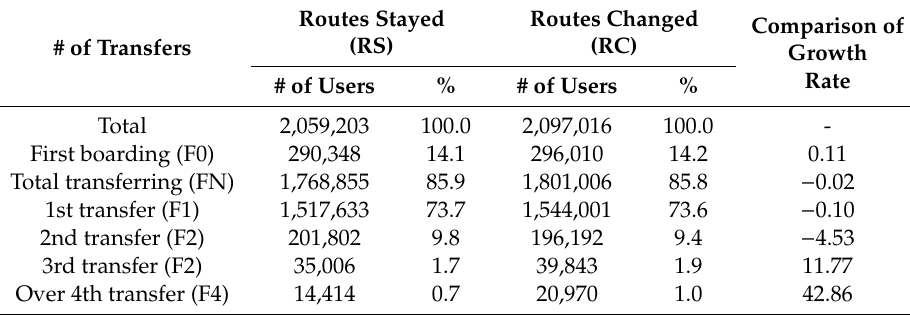
Table 8. Classification by bus combination and number of transfers.